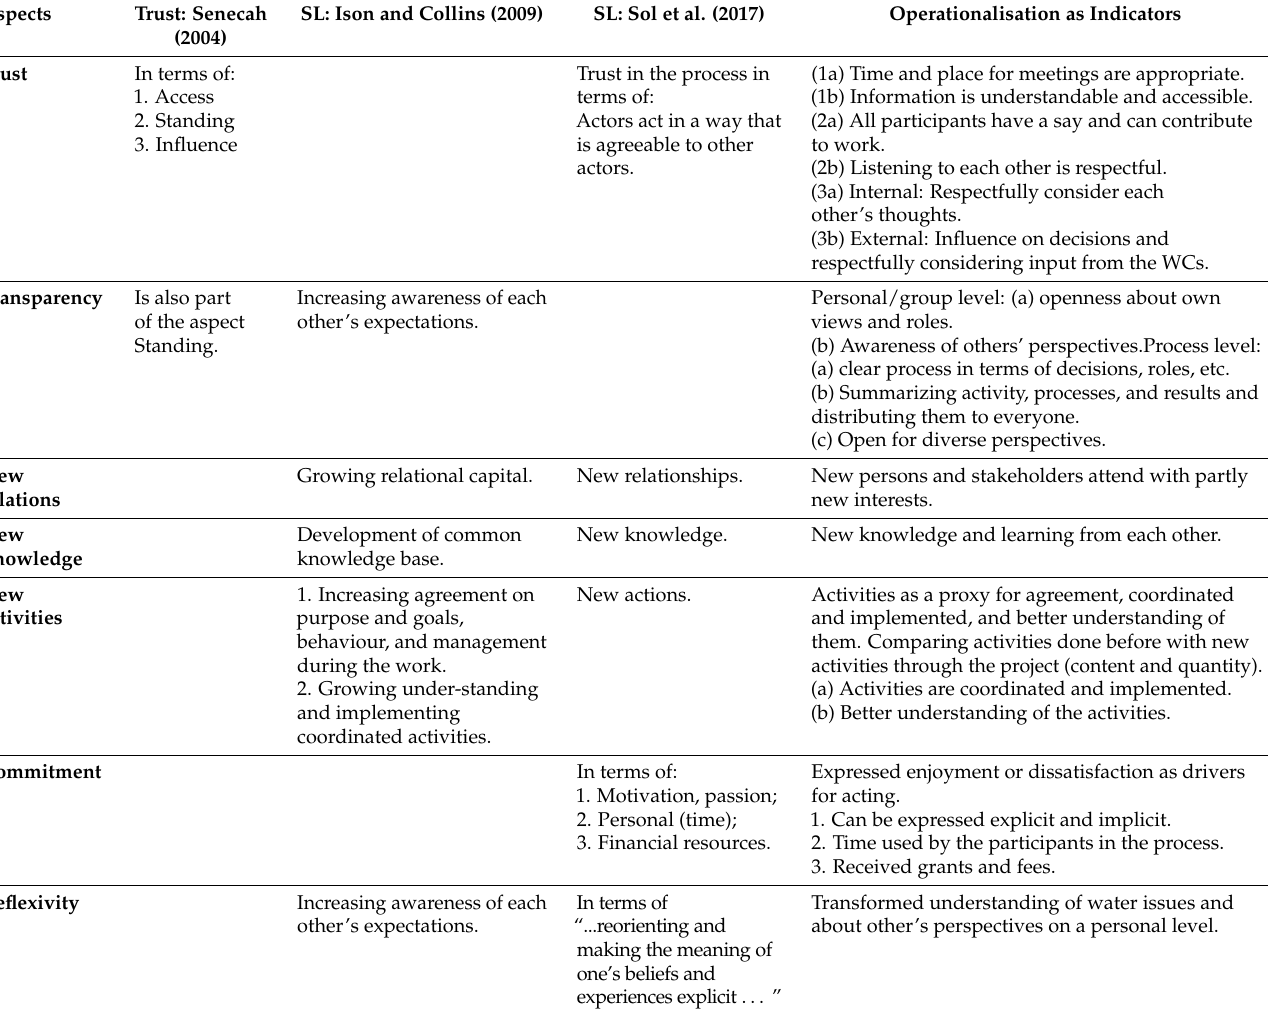
Table 1. Operationalisation of analytical categories in terms of indicators and data